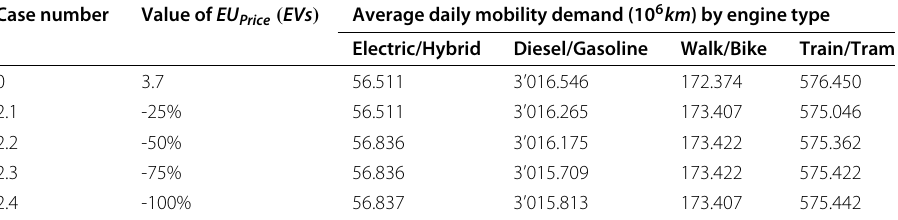
Table 5 Result of daily average mobility demand (10 6 km ) by engine type in scenarios of charging price